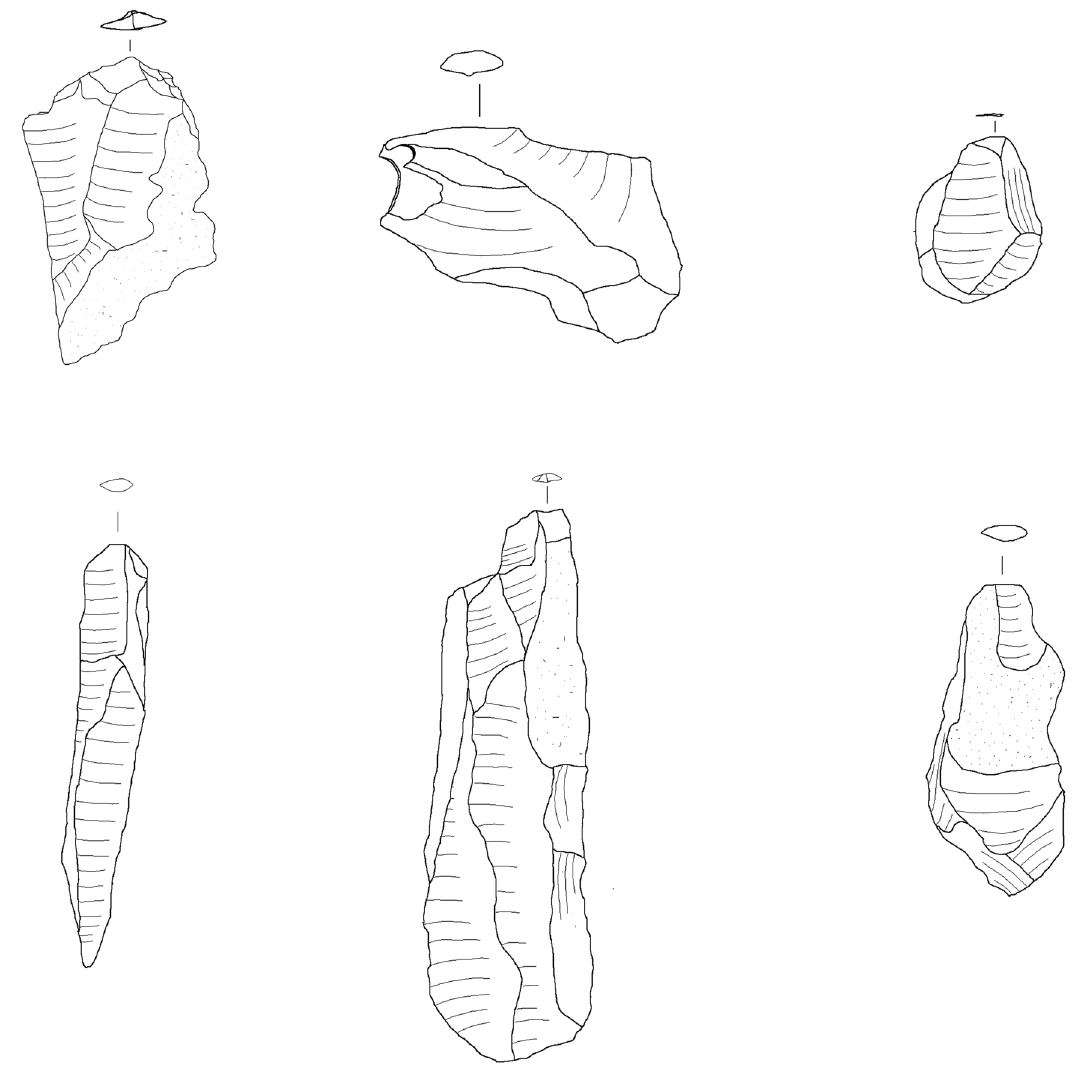
Figure 4: Typical debitage associated with Bexhill Point